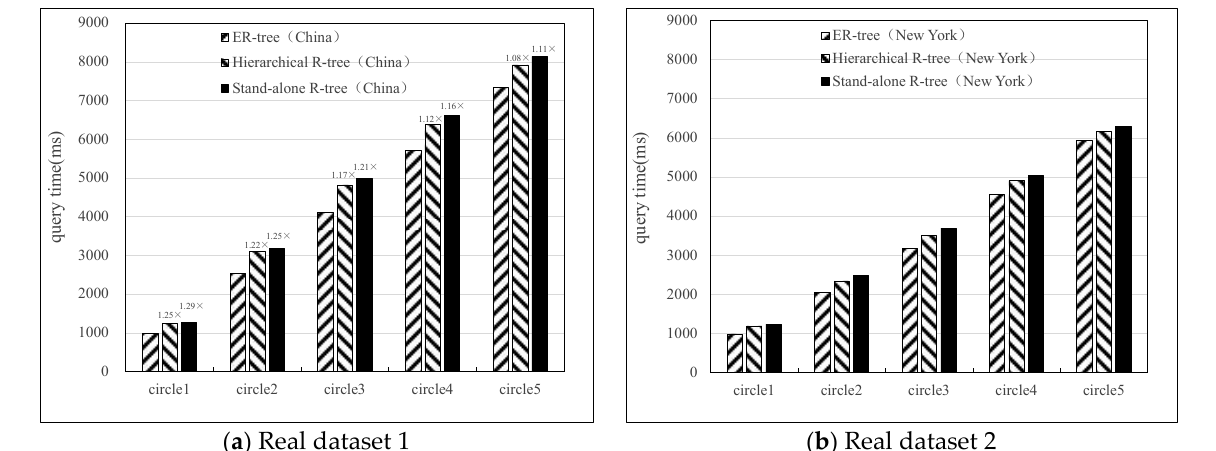
Figure 17. Comparison of the index circle query performance on the real dataset.